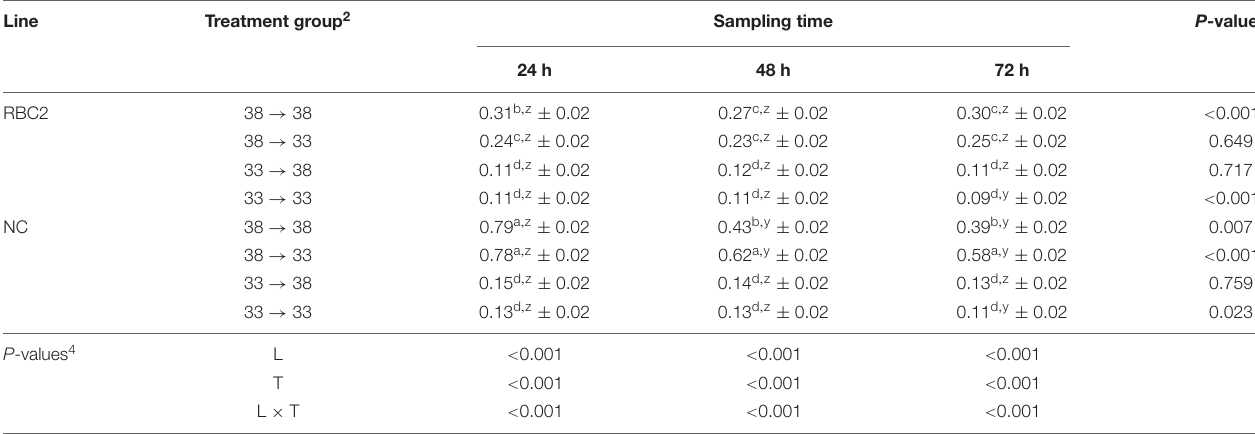
TABLE 6 | Effect of cold stress (33 ◦ C) on lipid accumulation during differentiation of satellite cells isolated from the pectoralis major muscle of Randombred Control Line 2 (RBC2) and Nicholas Commercial (NC) line turkeys 1 . Line Treatment group 2 Sampling